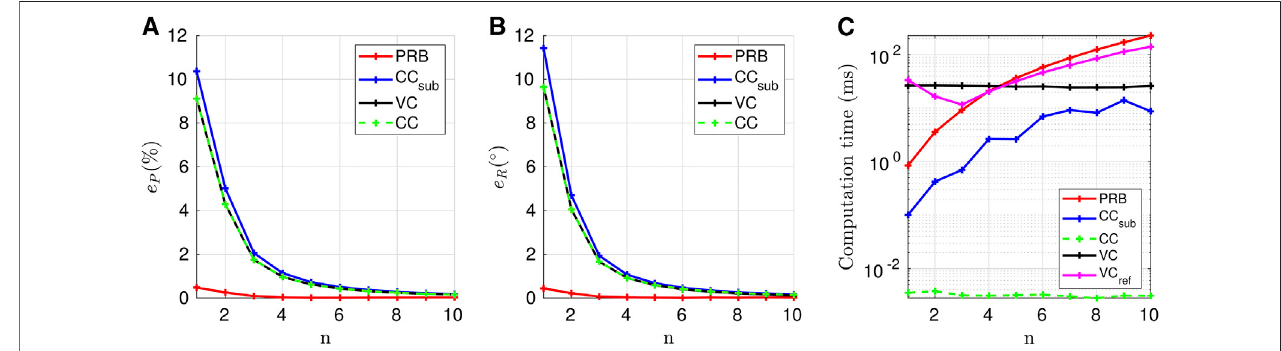
FIGURE10| Evolutionofthemodelsaccuracyaccordingtothenumberofdiskspersegment.Themetrics e p and e R representthedeviationofthetippositionand orientation respectively.